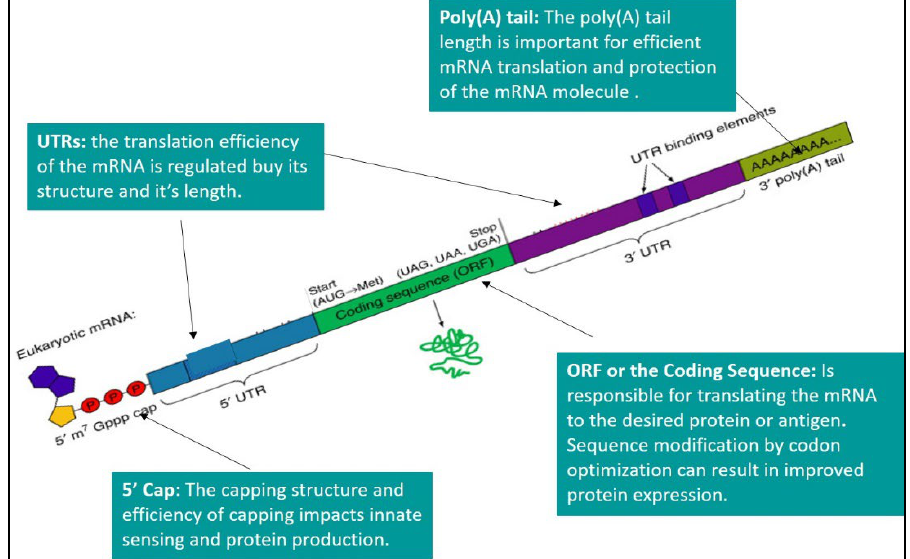
Figure 1. mRNA molecule structural components [25].